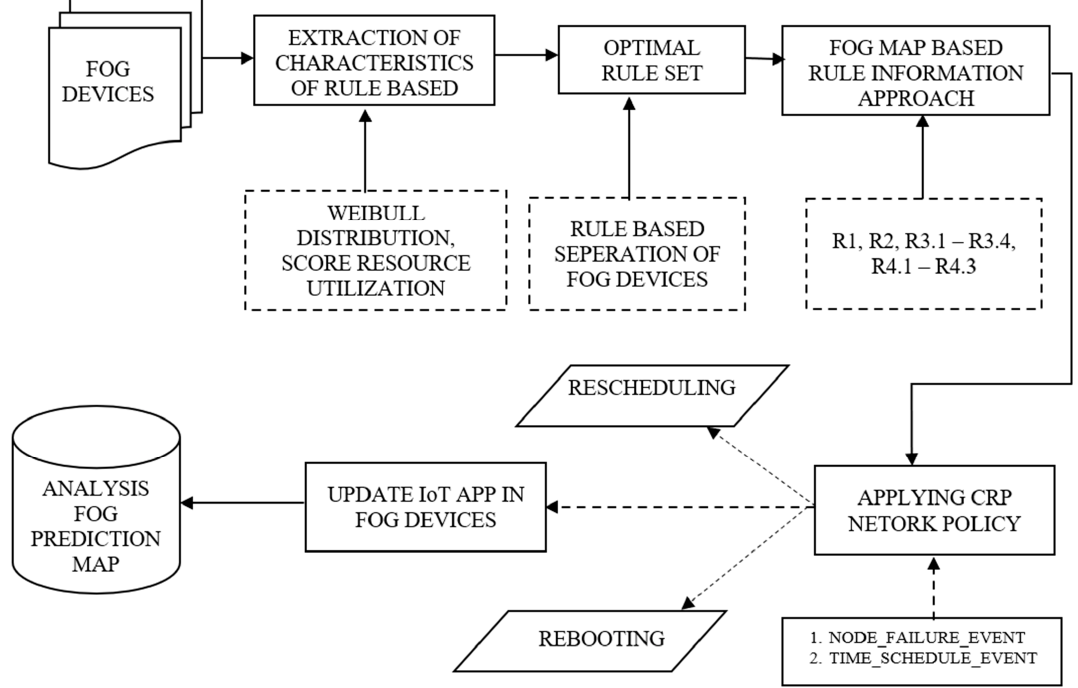
Figure 6. Architecture of CRP rule-based network.